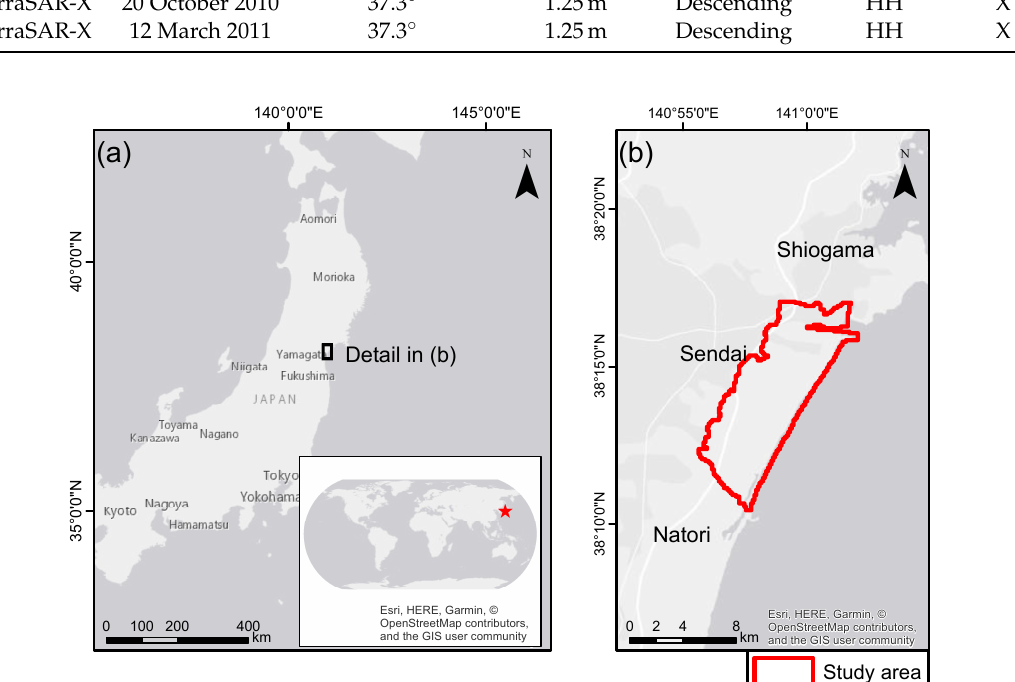
Figure 1. Study area: ( a ) Tohoku region in Japan; and ( b ) coastal areas of Sendai.